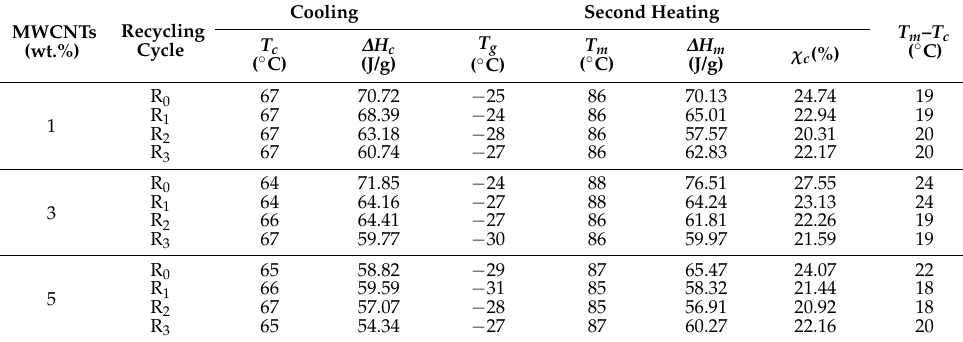
Table 1. DSC properties of EVA/MWCNT nanocomposites. MWCNTs